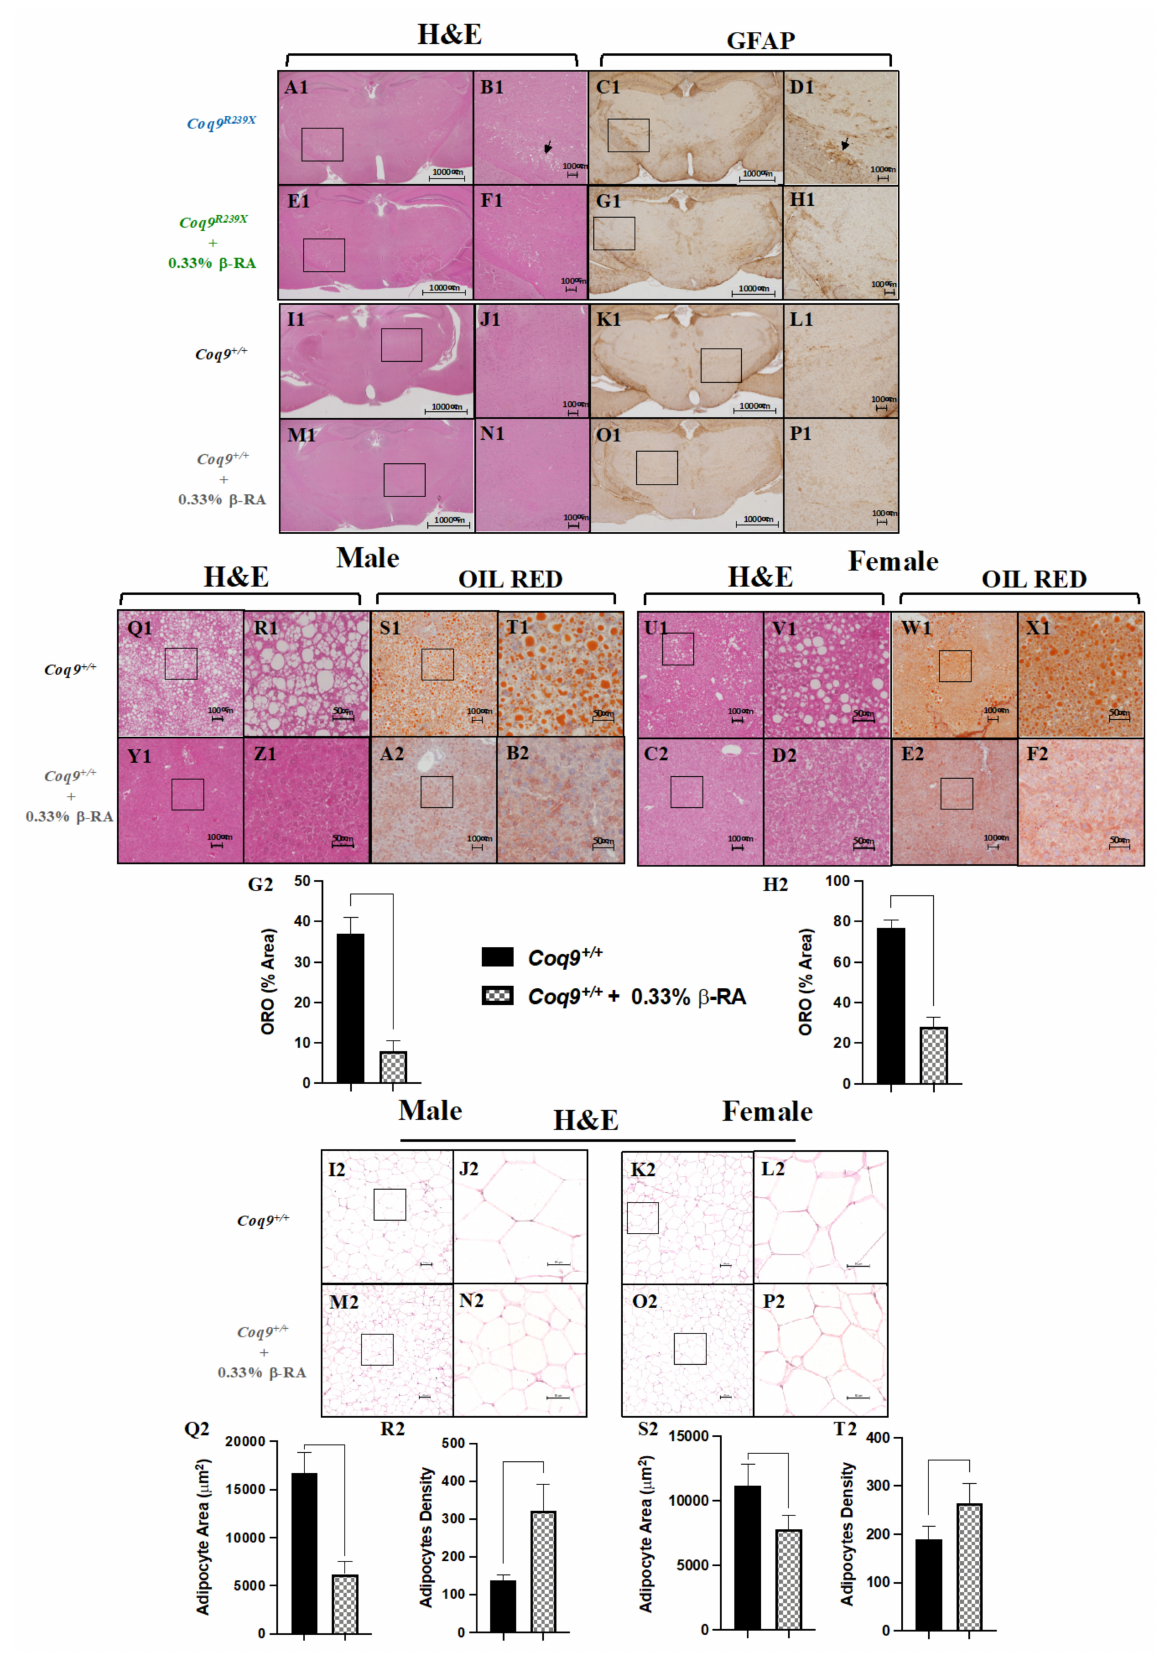
Figure 2. Morphological evaluation of symptomatic tissues from Coq9 R239X and Coq9 +/+ mice under the supplementation with 0.33% β -RA. ( A1 – P1 ) H&E stain and anti-GFAP immunohistochemistry in sections of the diencephalon from Coq9